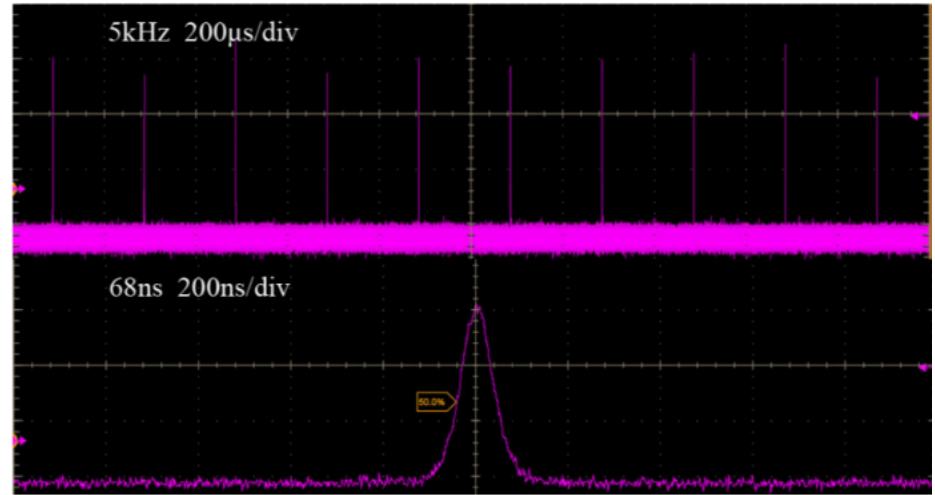
Figure 4. The temporal pulse trains and pulse profile of AO Q-switched Tm:YLF laser at the repetition frequency of 5 kHz.